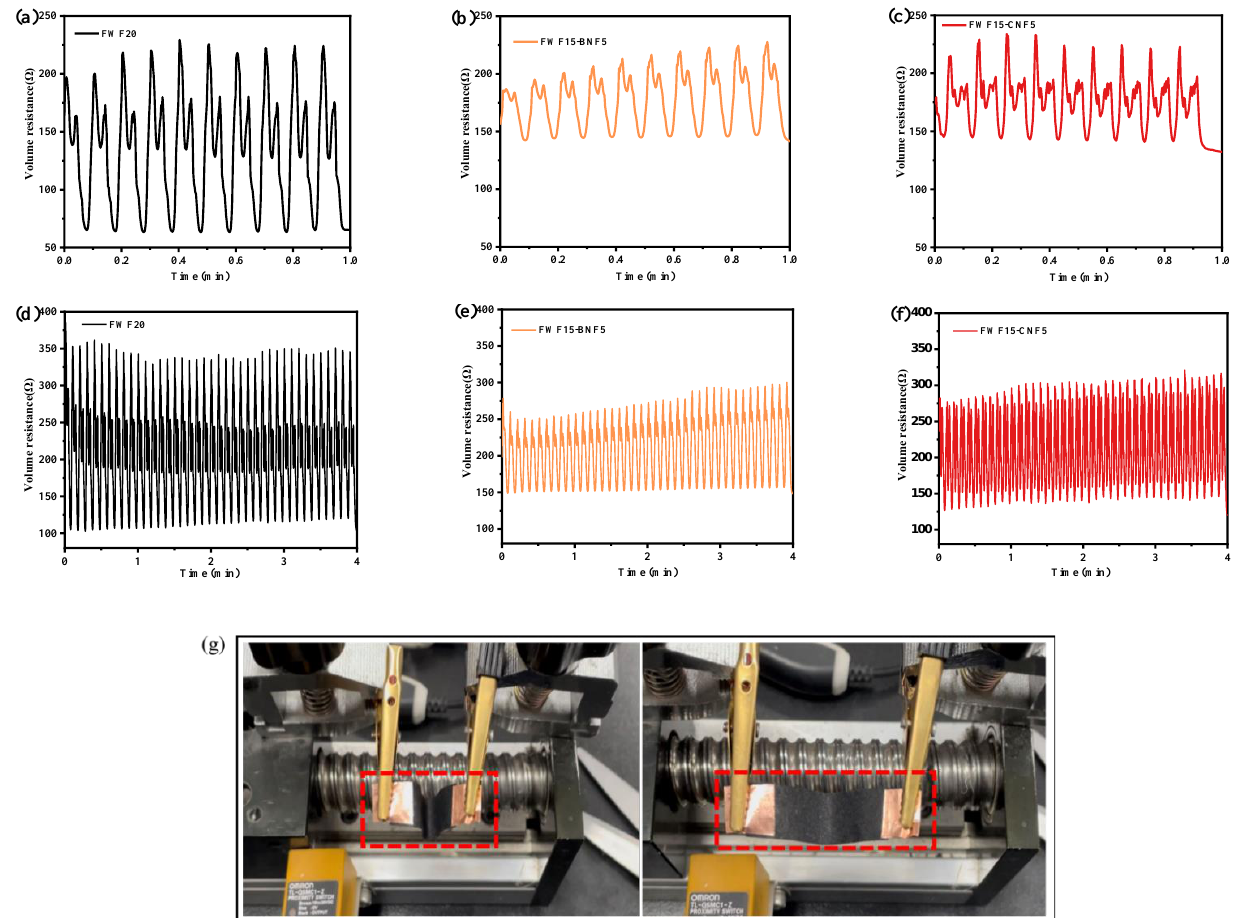
Figure 6. ( a – c ) Graph of sensing body resistance changes in paper-based electrodes bending-tensioning for one minute. ( d – f ) Graph of sensing body resistance changes in paper-based electrodes bending-tensioning for four minutes. ( g ) Photo of paper-based electrode bending-tension sensing body resistance test.